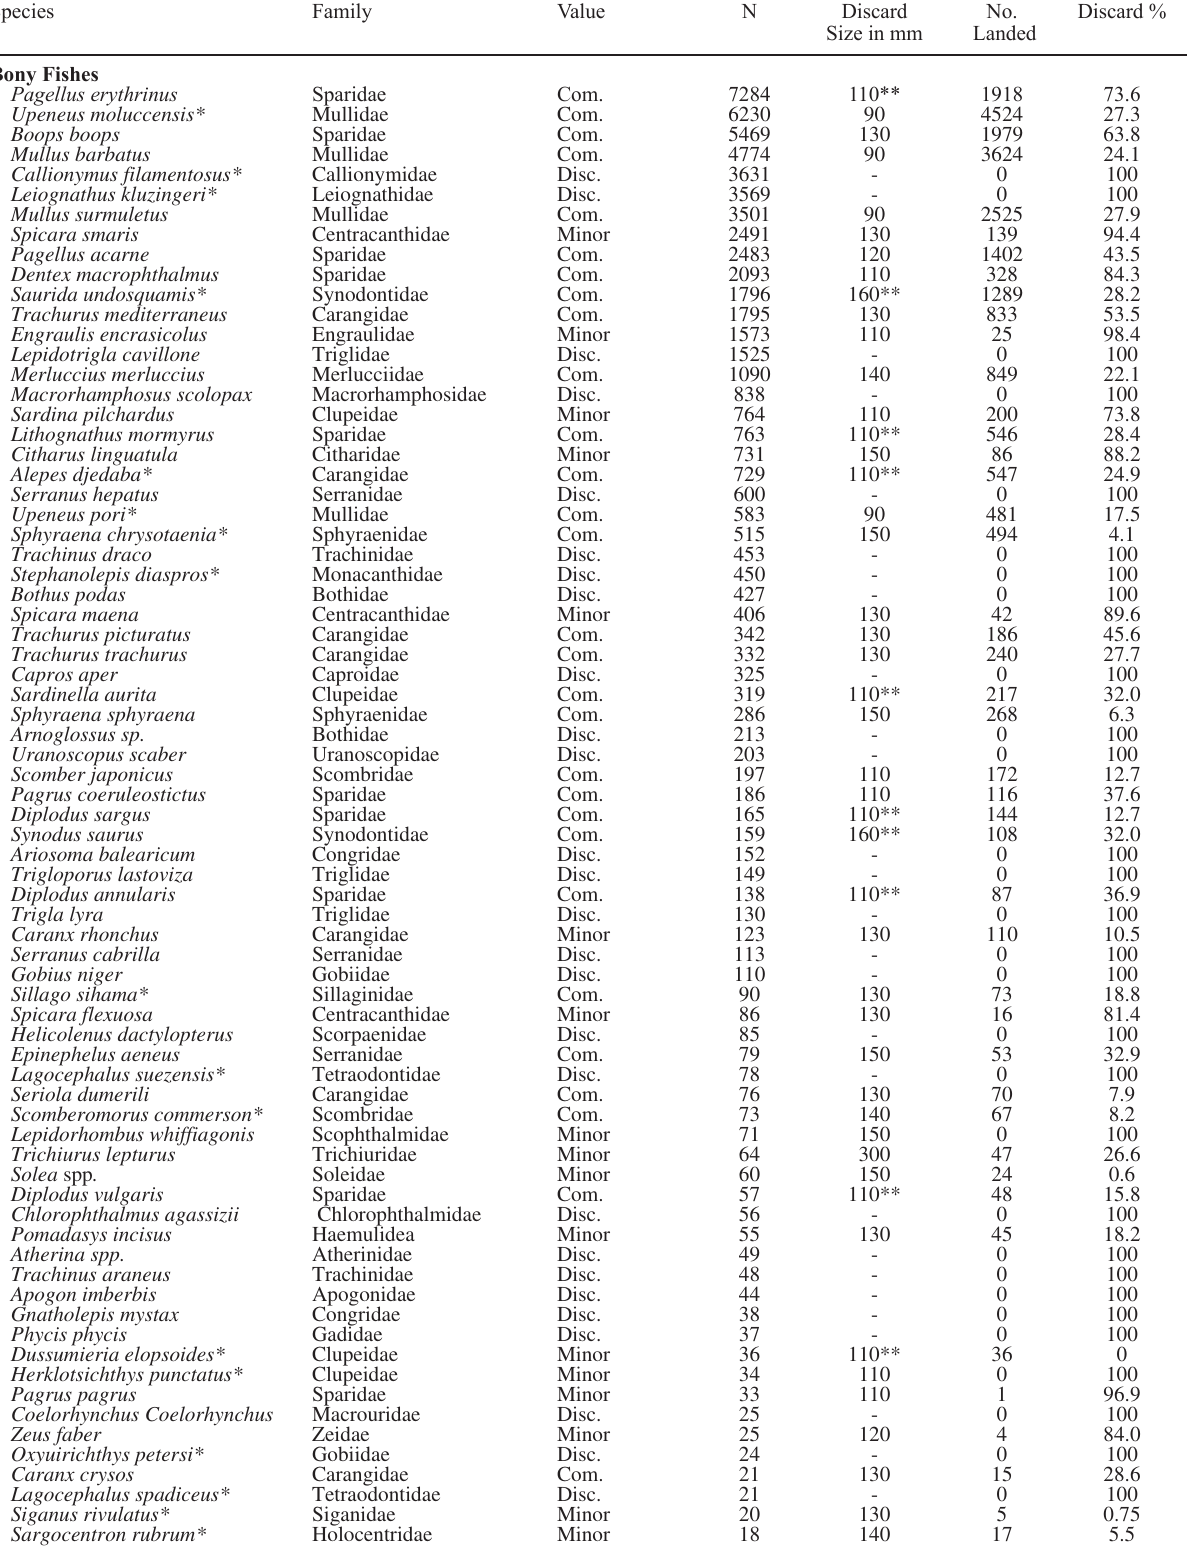
Table 1. – List of species recorded in surveys, their origin, commercial value and abundance in 324 trawl samples, as well as their landed and discarded fractions in the catch. N, number of specimens; Minor, minor commercial value; Com., commercial; Disc., discarded; * Lessepsian migrant; ** discard size was set according to MLS regulations; *** species were not separated in samples and were recorded as one taxa.